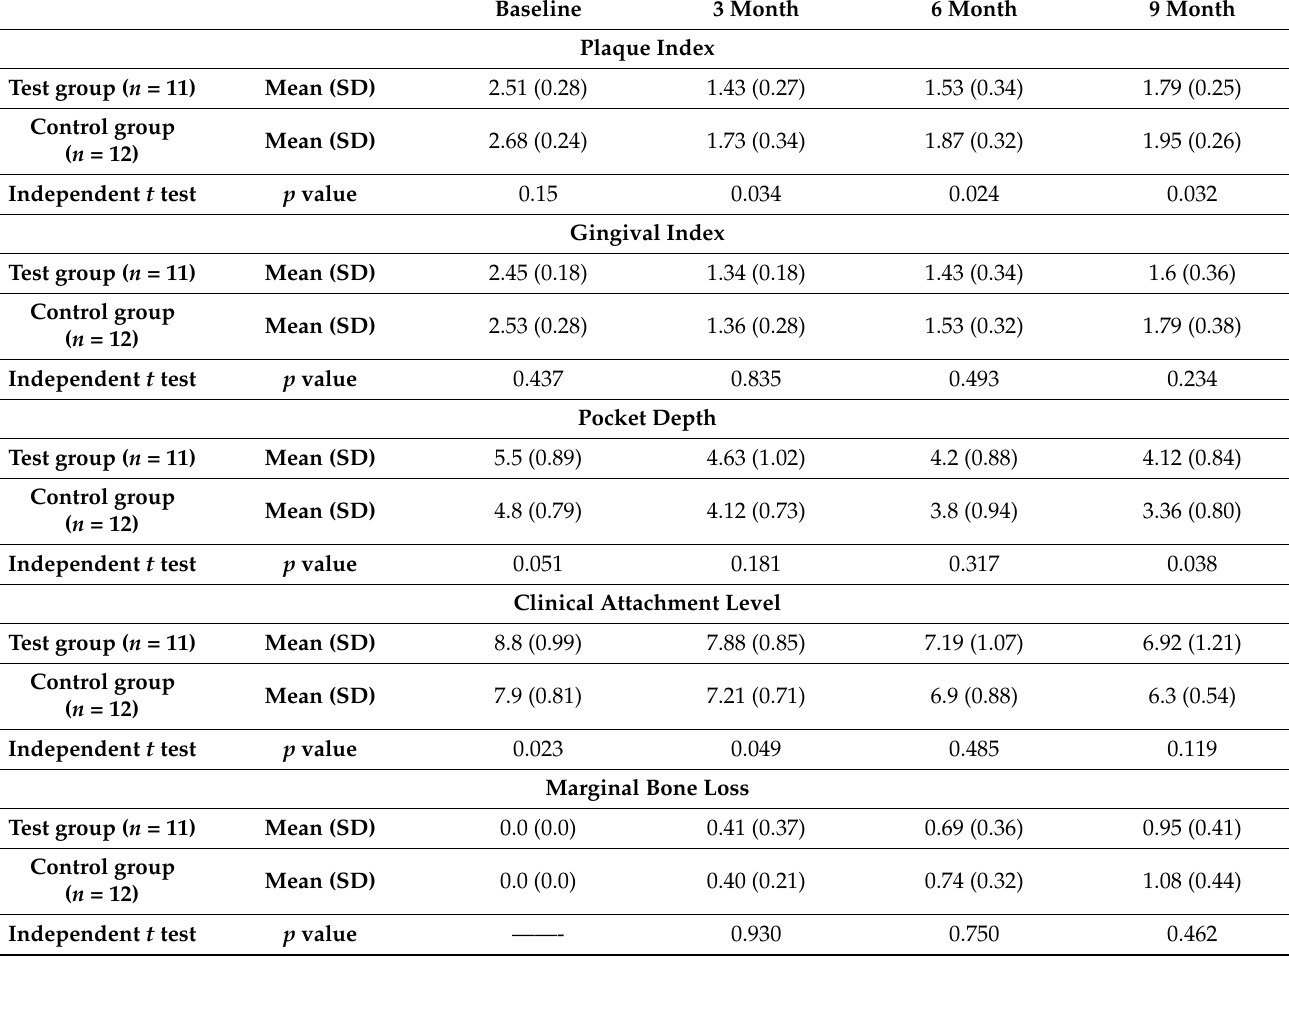
Table 5. Intergroup comparison of mean PI, GI, PD, CAL, and MBL in test and control groups at different time intervals (baseline, 3 months, 6 months, and 9 months, respectively).